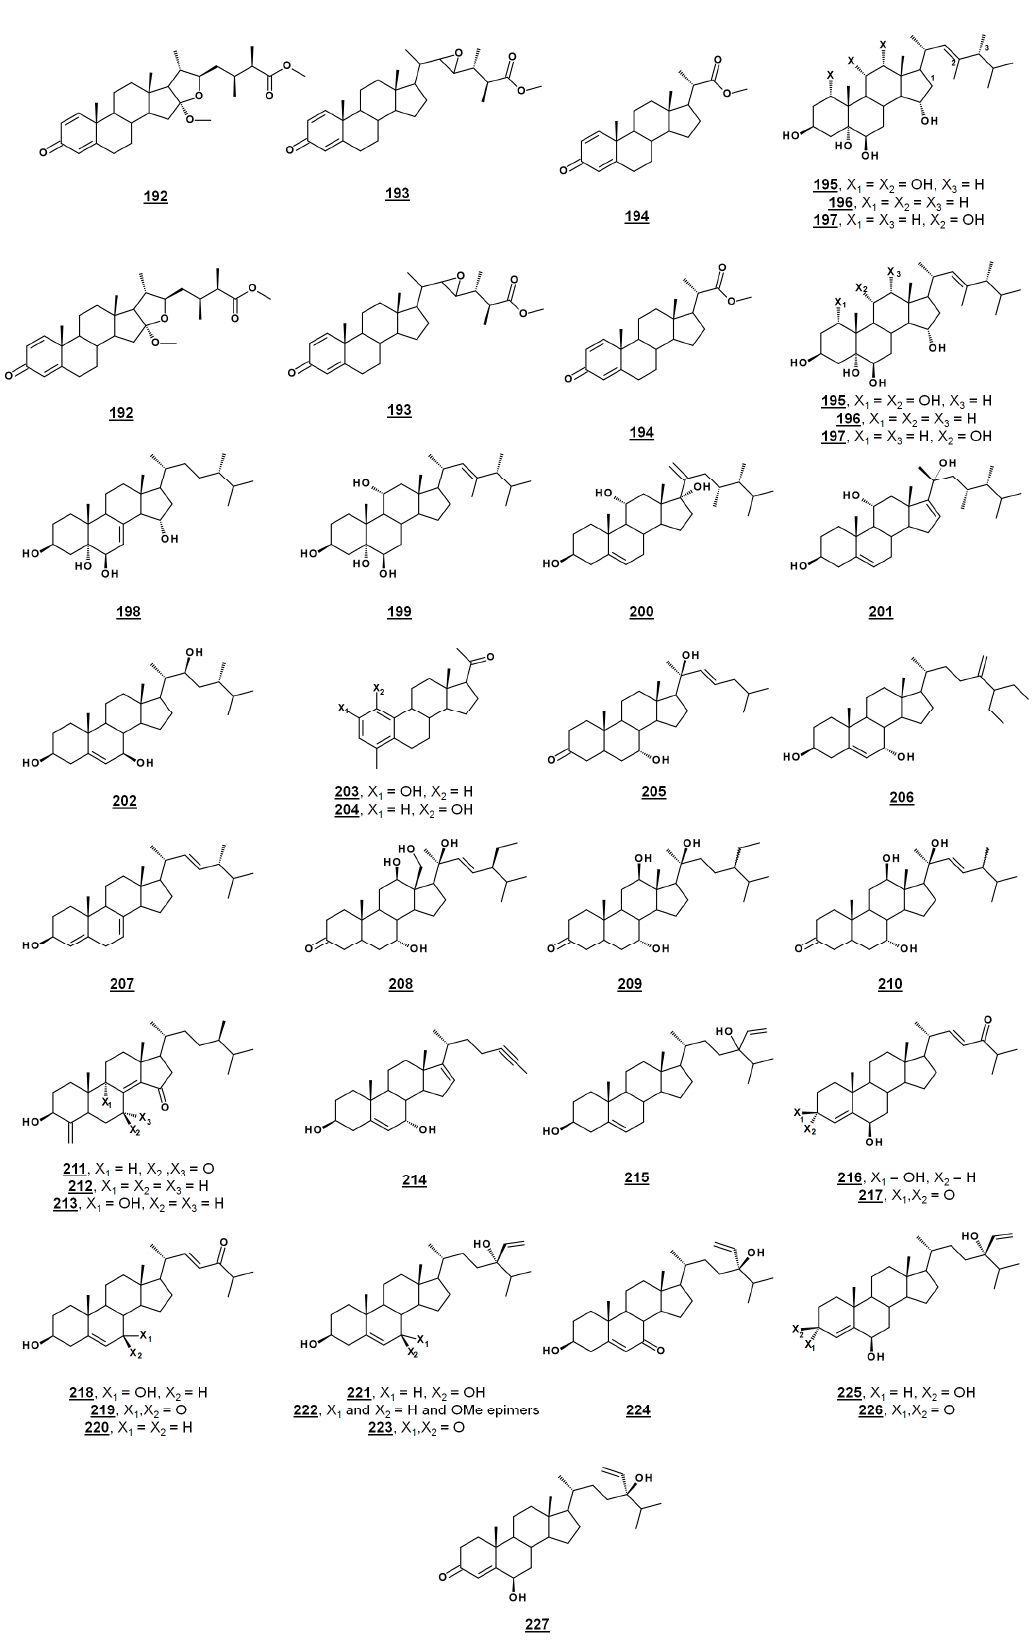
Figure 16. Bioactive sterols and steroids. Activities are given in Table 2.